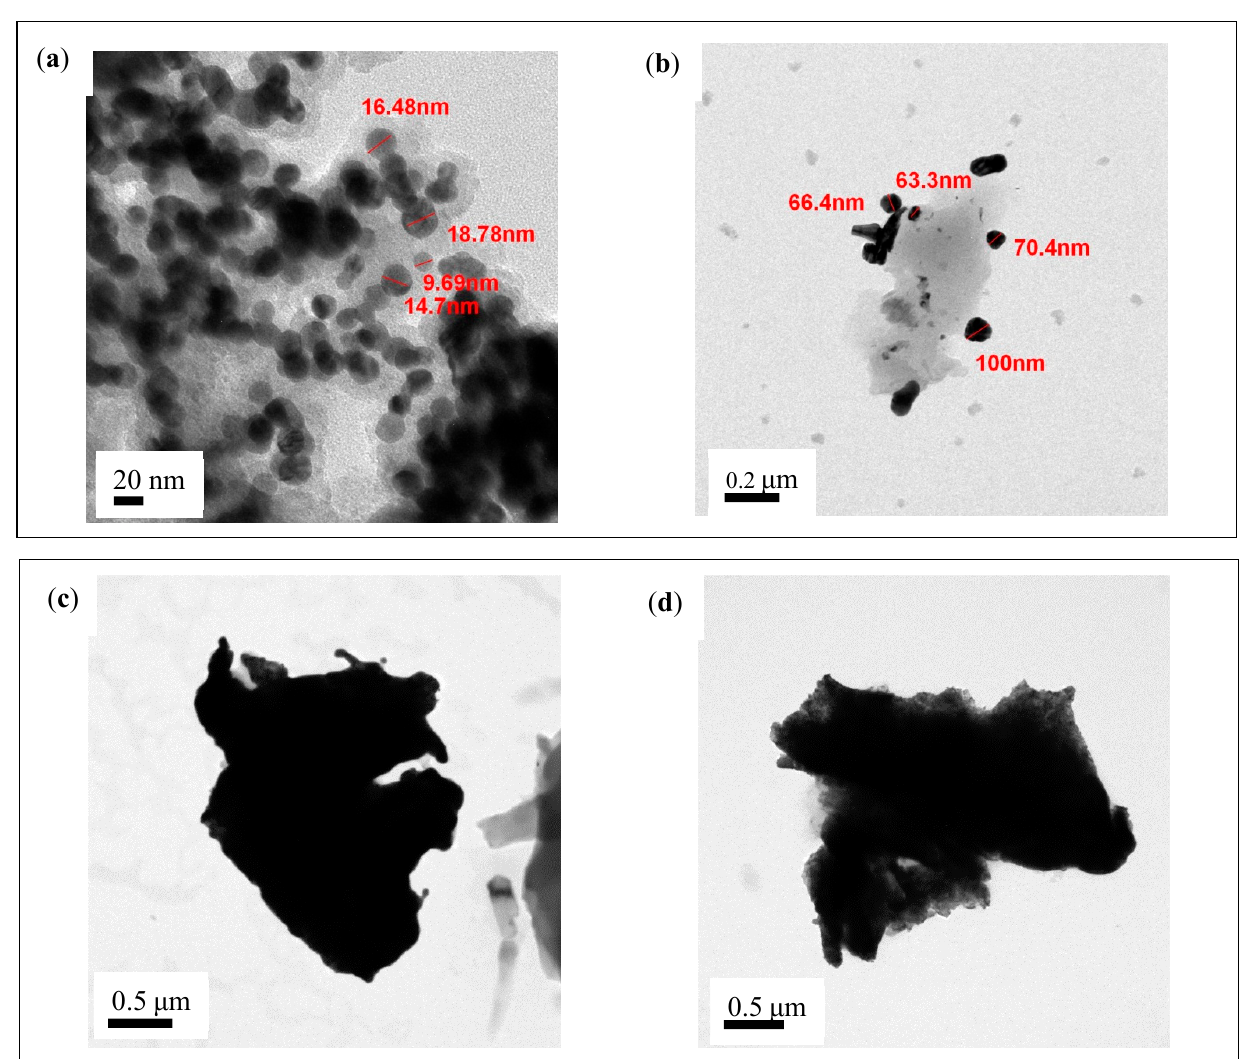
Figure 4. Growth solution is added to ( a ) 30, ( b ) 50, ( c ) 70, and ( d ) 90 μ L HNO 3 solution.